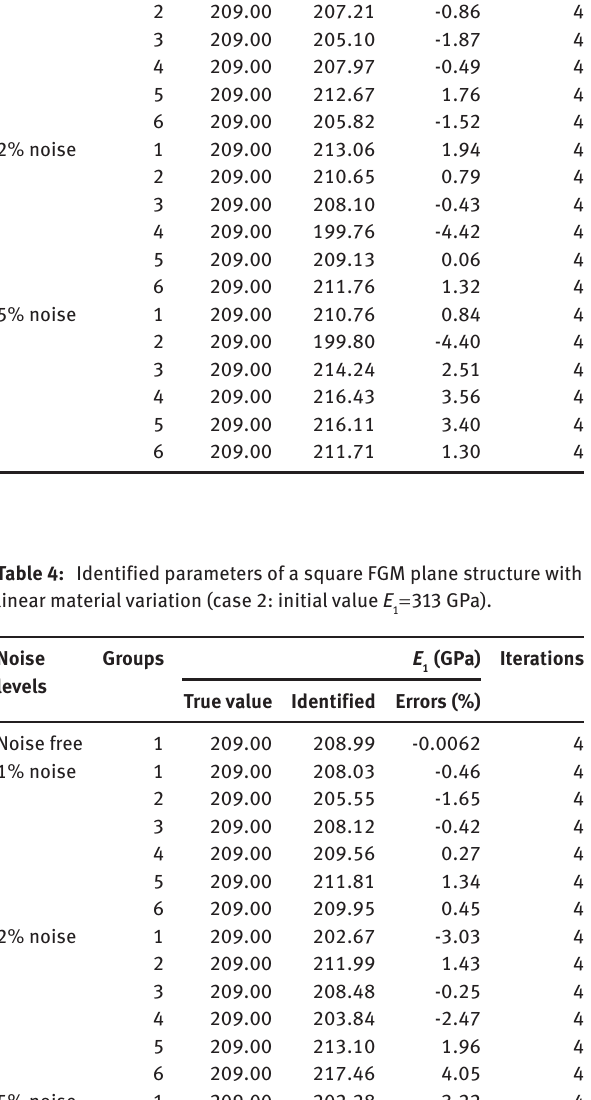
Table 3: Identified parameters of a square FGM plane structure with linear material variation (case 1: initial value E